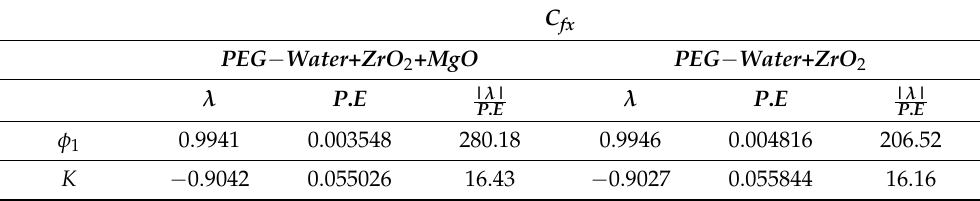
Table 3. Shear stress and a few other factors’ connection.